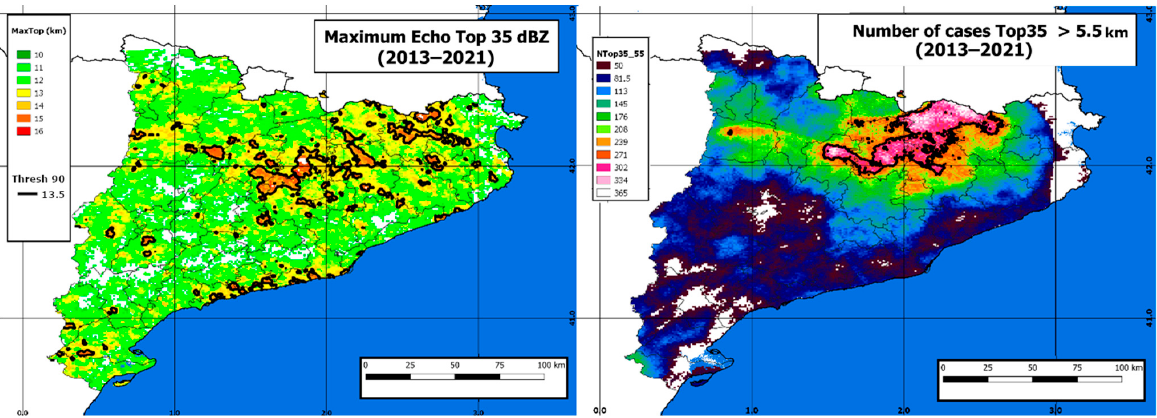
Figure 4. Same as Figure 3, for the TOP35, with a height threshold of 5.5 km. Areas with white color (left panel) indicate that maximum TOP35 did not exceed 10 km at any time during the period of study.